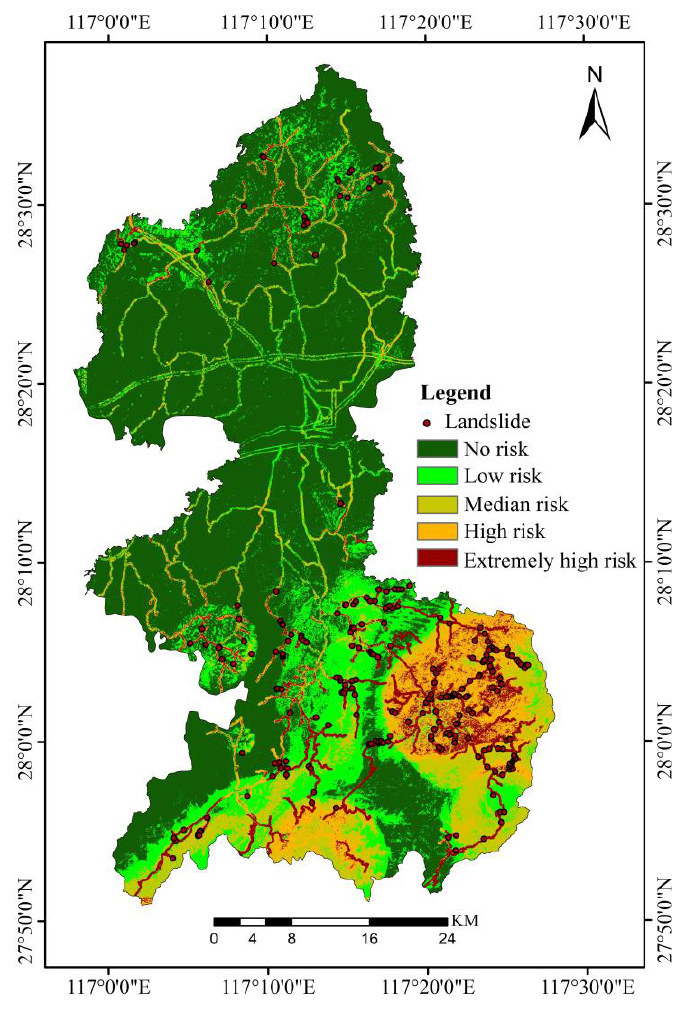
Figure 4. Landslide risk map.